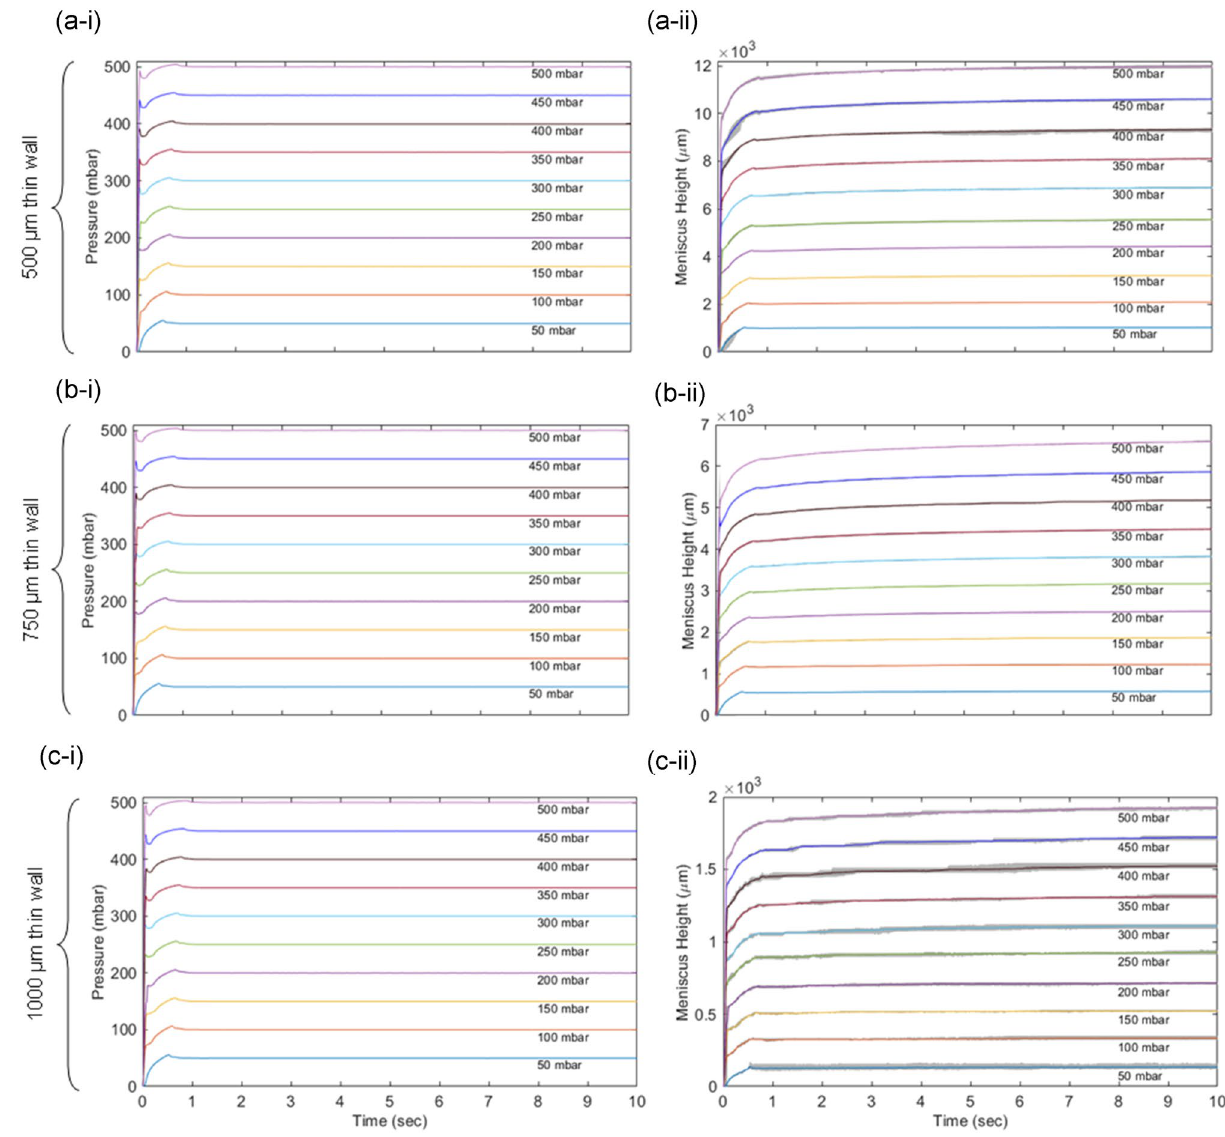
Figure 3. Input pressure and output meniscus height of three different thin wall chip geometries: ( a ) 500 µm. ( b ) 750 µm. ( c ) 1000 µm. The meniscus height response increases linearly with application of pressure and reduces as we increase the thin wall